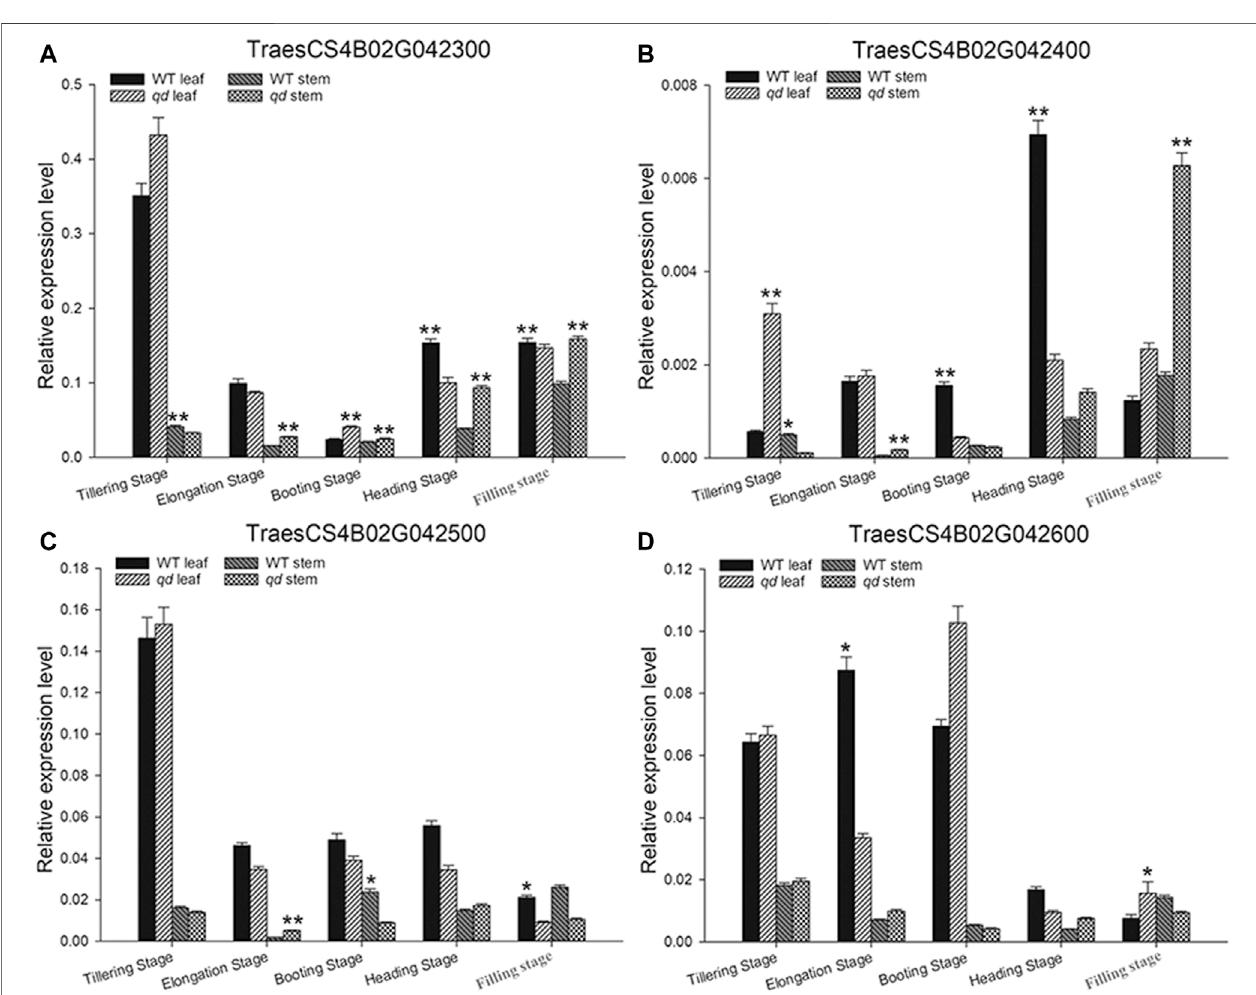
FIGURE 7 | Expression analysis of candidate genes in different developmental stages and tissues. (A) – (D) indicate the genes TraesCS4B02G042300 , TraesCS4B02G042400 , TraesCS4B02G042500 , and TraesCS4B02G042600 , respectively. “ * ” indicates that the differences between qd and the WT are signi fi cant at the 0.05 level; “ ** ” indicates that the differences between qd and the WT are signi fi cant at the 0.01 level.